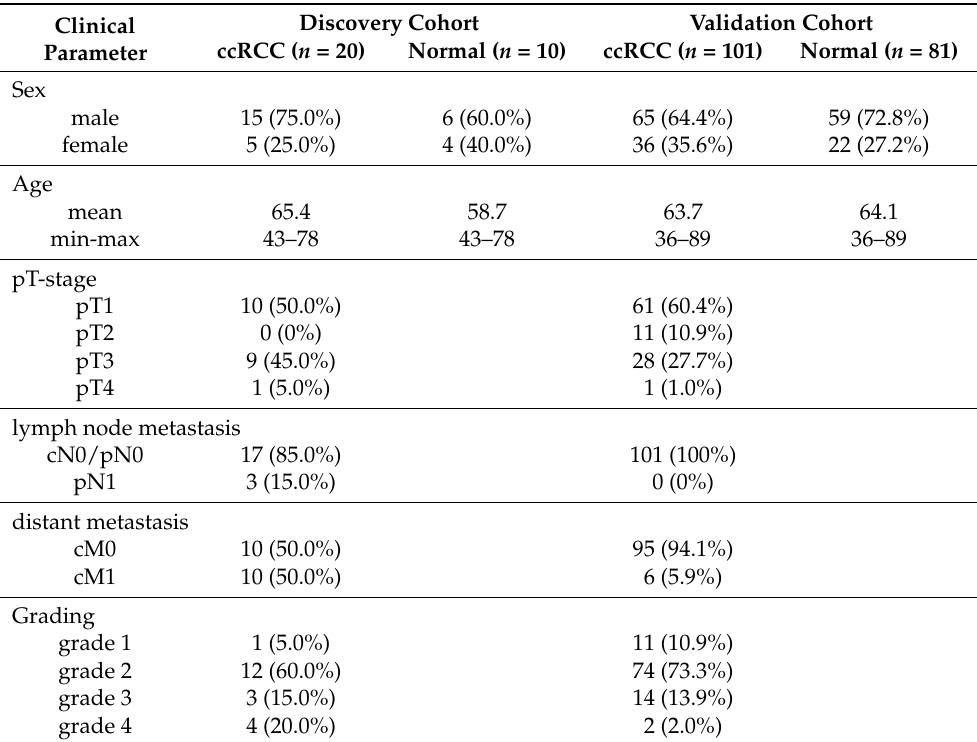
Table 1. Clinicopathological parameters of the study